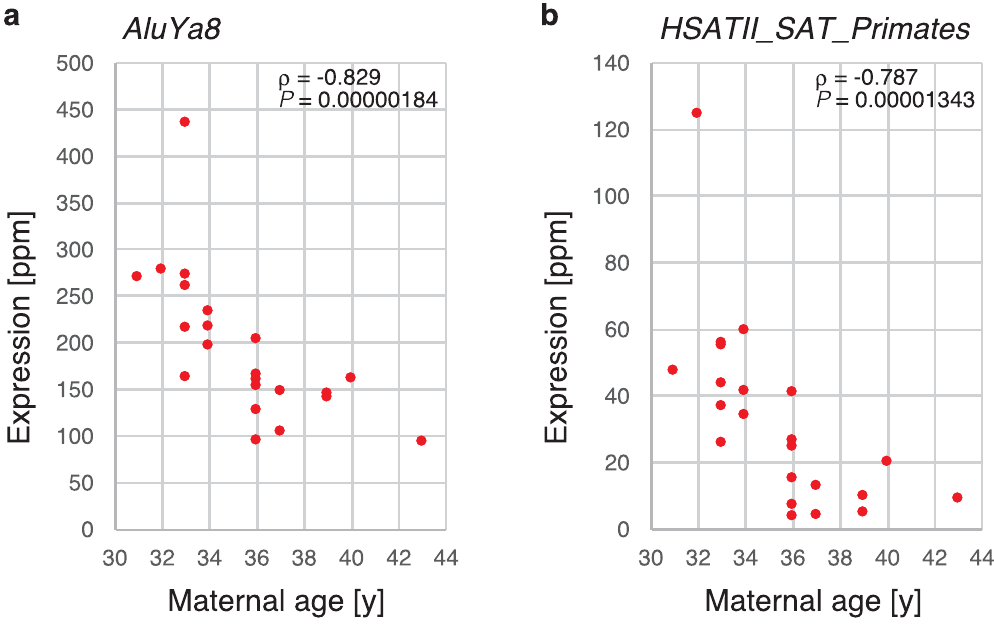
Figure 5. Alu and major satellite transcript expression according to parental age. AluYa8 expression levels ( a ) and HSATII ( b ) were plotted against the maternal